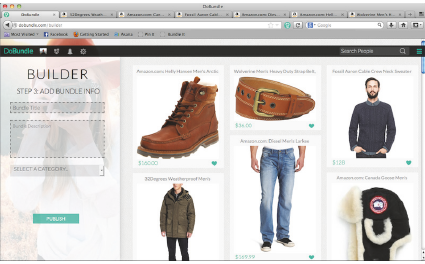
Figure 8: Last step before publishing a user’s “Hook” image and product collection